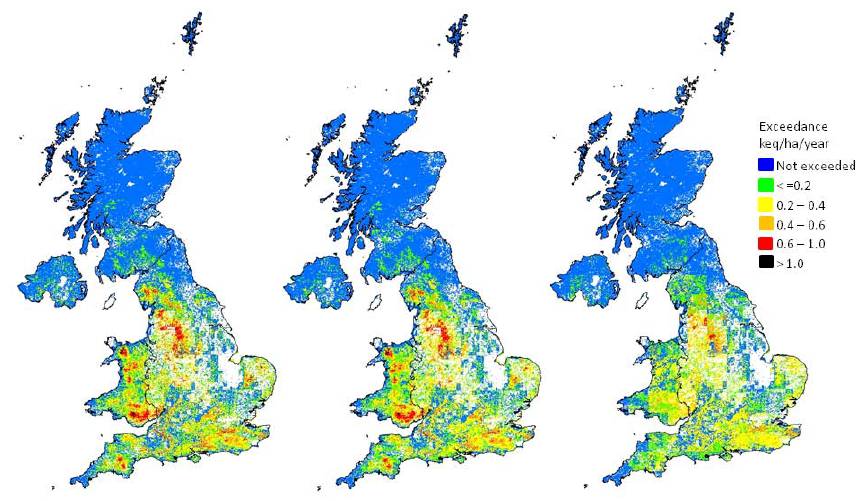
Fig. 6a. Exceedance of 5th percentile nutrient nitrogen critical loads for the UK using modelled deposition data with resolutions of: 1km (left); 5km (centre); 50km